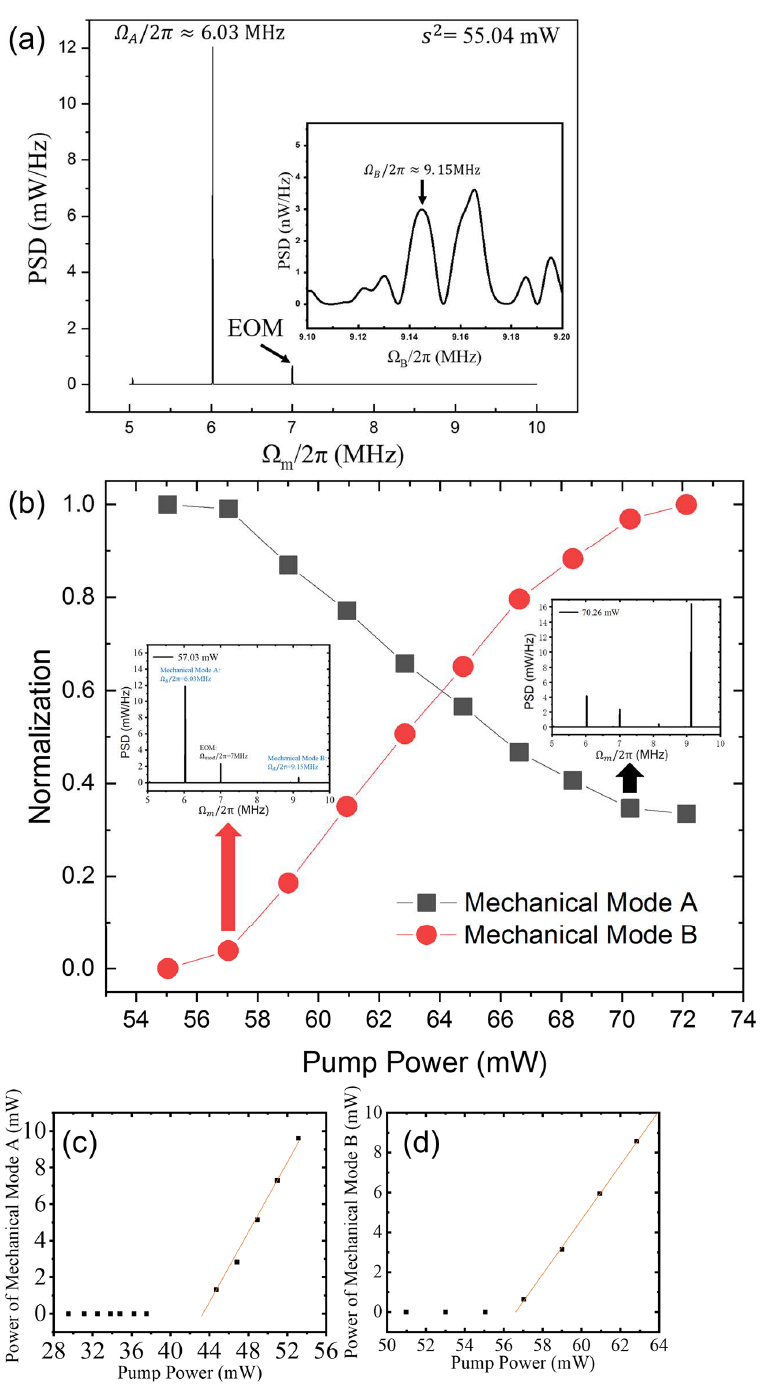
Figure 3. ( a ) Power spectrum of transmitted light ( s 2 = 55.04 mW) obtained by the spectrometer. Insert: Power spectrum at mechanical mode B after enlarging the vertical coordinate. ( b ) Intensities of mechanical modes A and B at different pump laser powers. Insert: Power spectrum (linear coordinate) at s 2 = 57.03 mW and s 2 = 70.26 mW. ( c ) Variation of mechanical mode A intensity at different pumping laser powers. ( d ) Variation of mechanical mode B intensity at different pumping laser